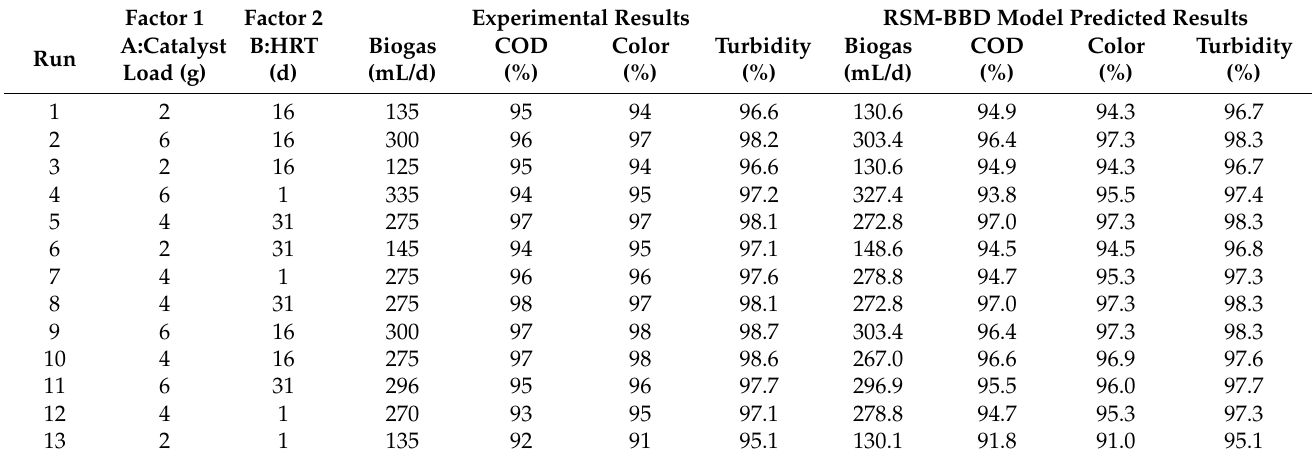
Table 4. The models’ variables depict the two-factor interactions between the catalyst